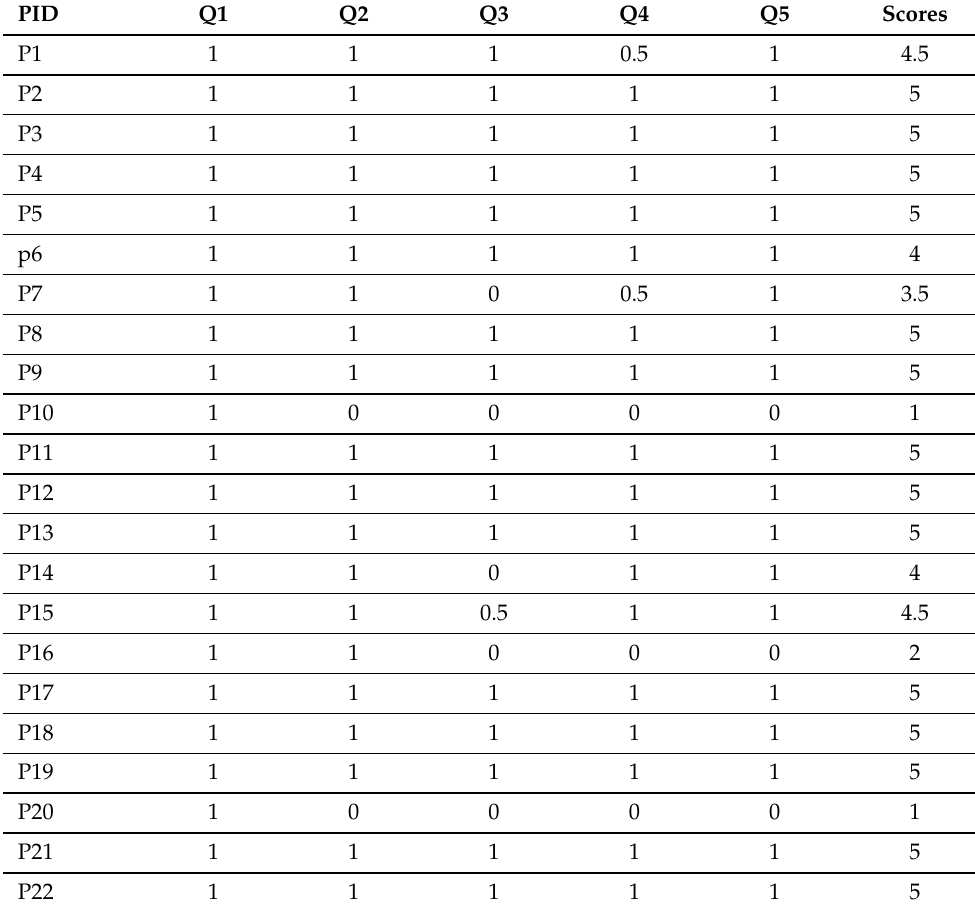
Table 1. Quality assessment scores for included review